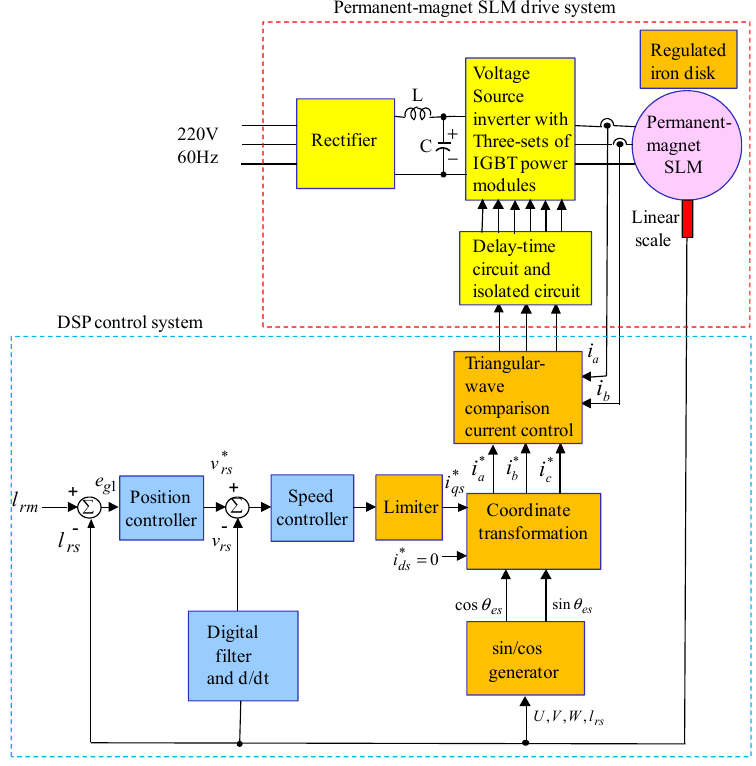
Figure 1. Formation of DSP FOC permanent-magnet synchronous linear motor (SLM) drive system.